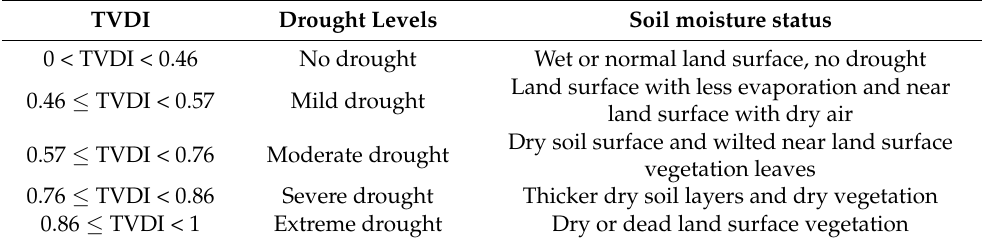
Table 3. Di ff erent levels of the Temperature Vegetation Drought Index.